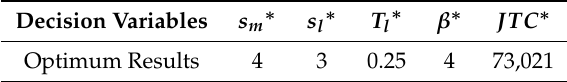
Table 4. Optimal outcomes of the corresponding decision